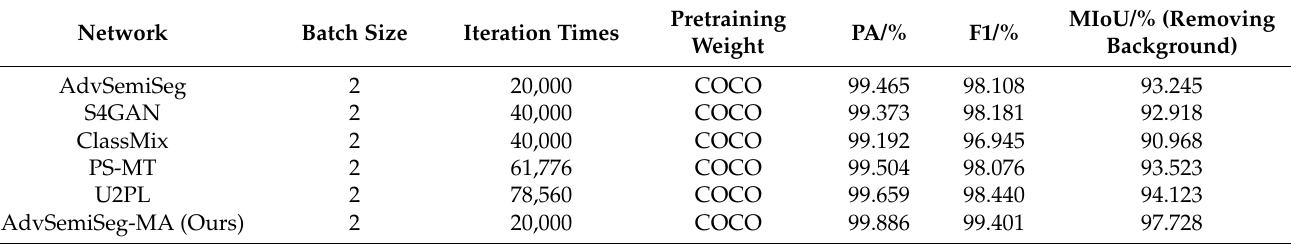
Table 4. Comparison of semi-supervised methods and our method for segmentation based on the synthesized assembly depth image